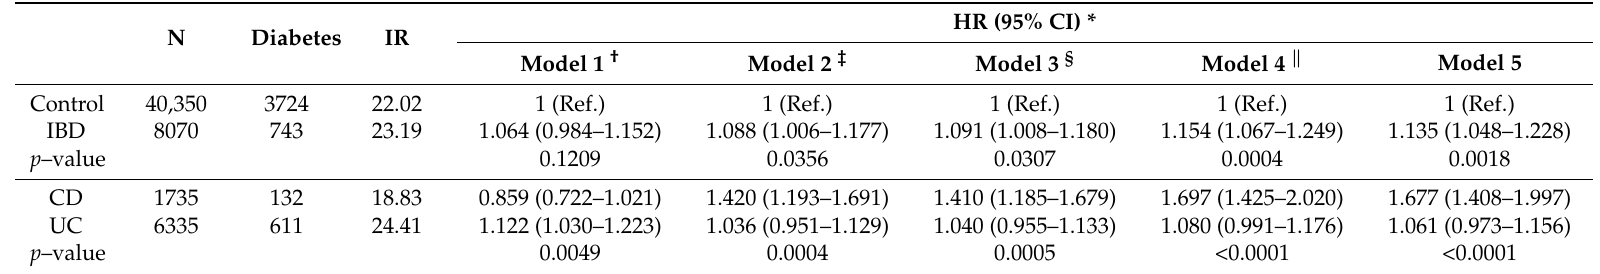
Table 2. Incidence and risk of diabetes in inflammatory bowel